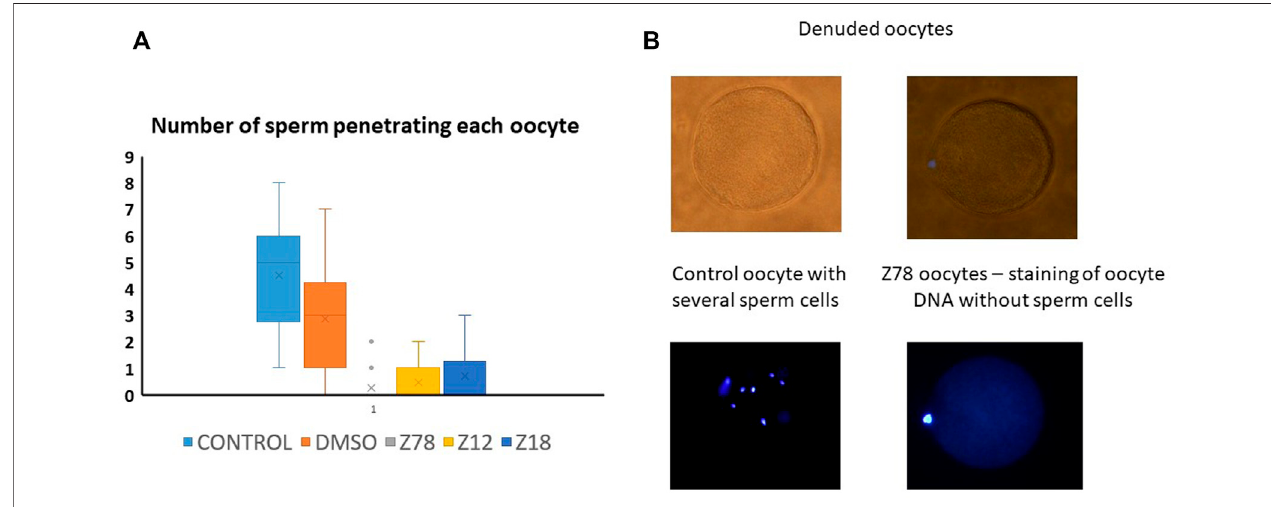
FIGURE 5 | Z786028994, Z1290281203, and Z1290281203 (marked Z78, Z12, and Z18) demonstrated penetration blockage at a concentration of 100 μ M. (A) Number of penetrated human sperm cells into denuded hamster oocyte compared to control and DMSO. All molecules presented in the graph were tested at a concentration of 100 µM. The three tested molecules demonstrated inhibition of penetration, with the most potent inhibition by Z786028994 molecule. (B) Representative bright fi eld and DAPI images of oocytes after penetration assay. Several sperm cells demonstrated inside the oocytes in the control group compared to no sperm cells penetrating the oocytes when incubated with Z786028994 molecule (just staining of the polar body).